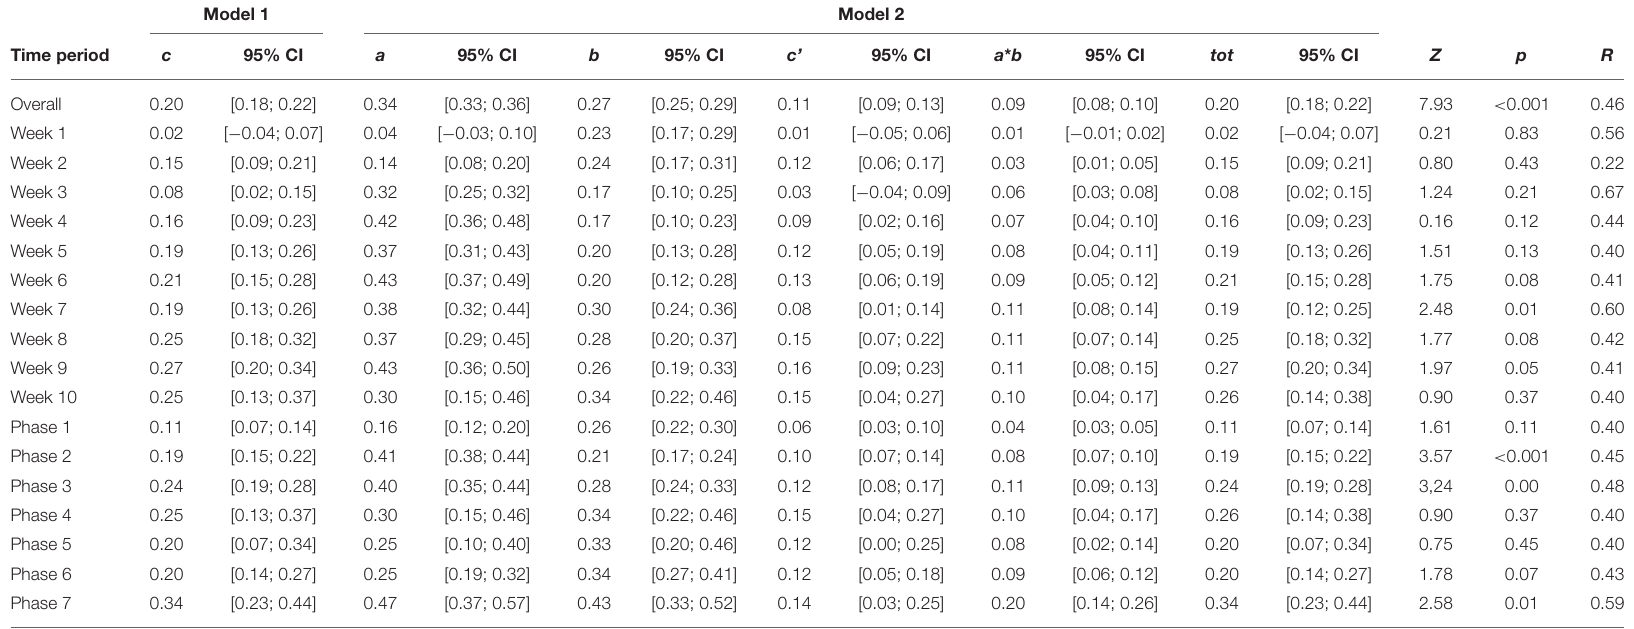
TABLE 2 | Mediation analysis results for Hypothetical protective behavior (HPB) credibility-alertness-behavior (CAB)